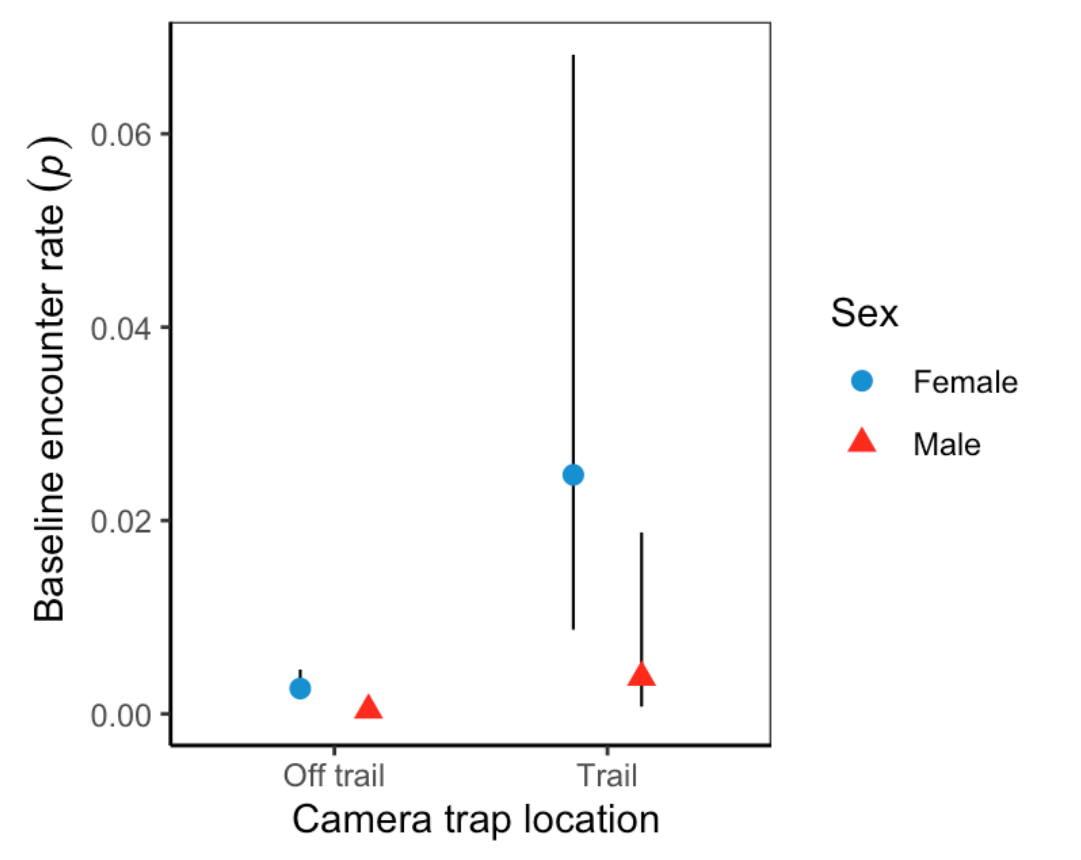
Figure 5. Sex-/camera trap location-specific effect on jaguar baseline encounter rates, from top model structure in Sector Santa Rosa, Guanacaste Conservation Area, Northwestern Costa Rica. The black line represents 95% confidence intervals. Table 4. Maximum likelihood parameter estimates from the top model of jaguar density, that included constant density D (~1), based line detection varied according to sex (sex) and trail/off trail camera location (loc), sex- and session-specific space use: sig (~ session+ sex), and sex ratio Ψ, in Sector Santa Rosa, Guanacaste Conservation Area, Northwestern Costa Rica.